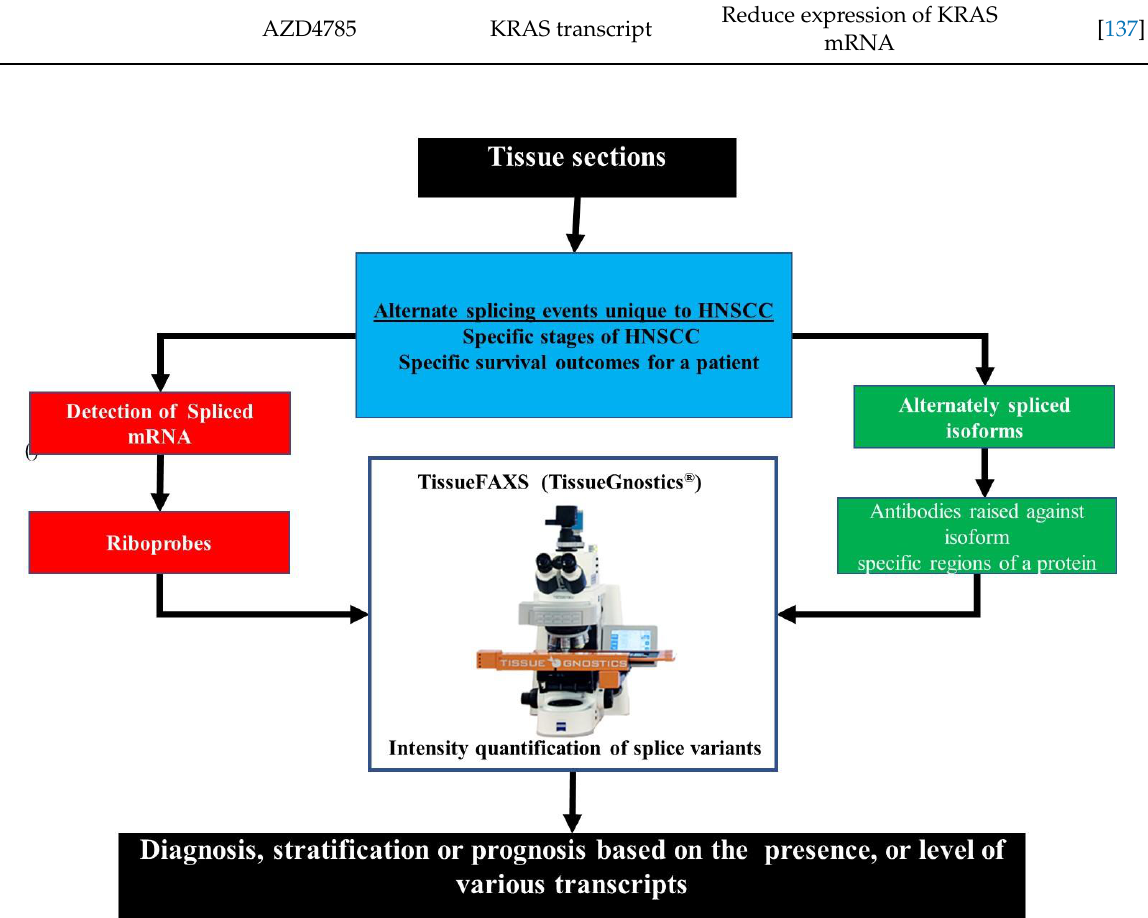
Figure 7. An example of a workflow to detect alternative splicing events using an automated detection and quantification system. The differences in the profiles of splicing events can be used to diagnose HNSCC, detect if the HNSCC is related to human papillomavirus (HPV) infection or stratify patients based on cancer stage and severity. Either riboprobes specific for mRNA transcripts or antibodies that are raised against portions of different protein isoforms that are unique to specific isoforms can be used to detect variants. An automated quantification system, such as the TissueFAXS Plus from TissueGnostics, can be used to rapidly and accurately detect and quantify the levels of these variants without the possible inaccuracies introduced by a subjective assessment by a histologist.